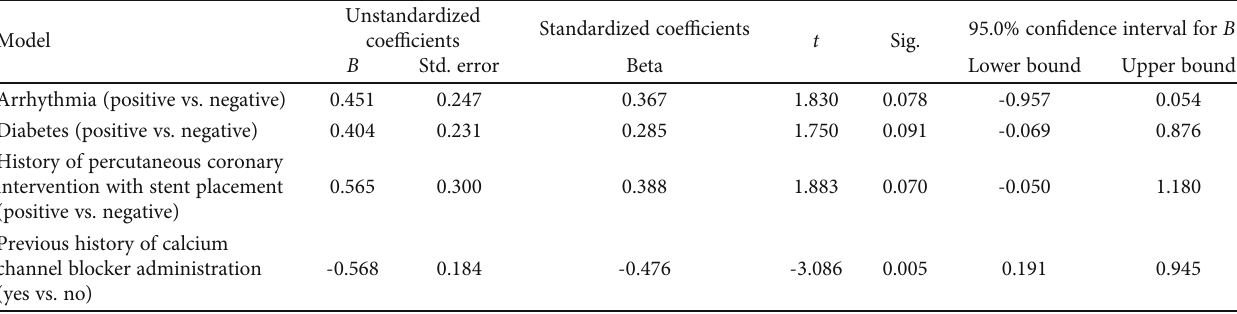
Table 6: Linear regression taking mRS score upon hospital admission as the dependent variable and sociodemographic factors, past medical history, and medication history as the independent variables.